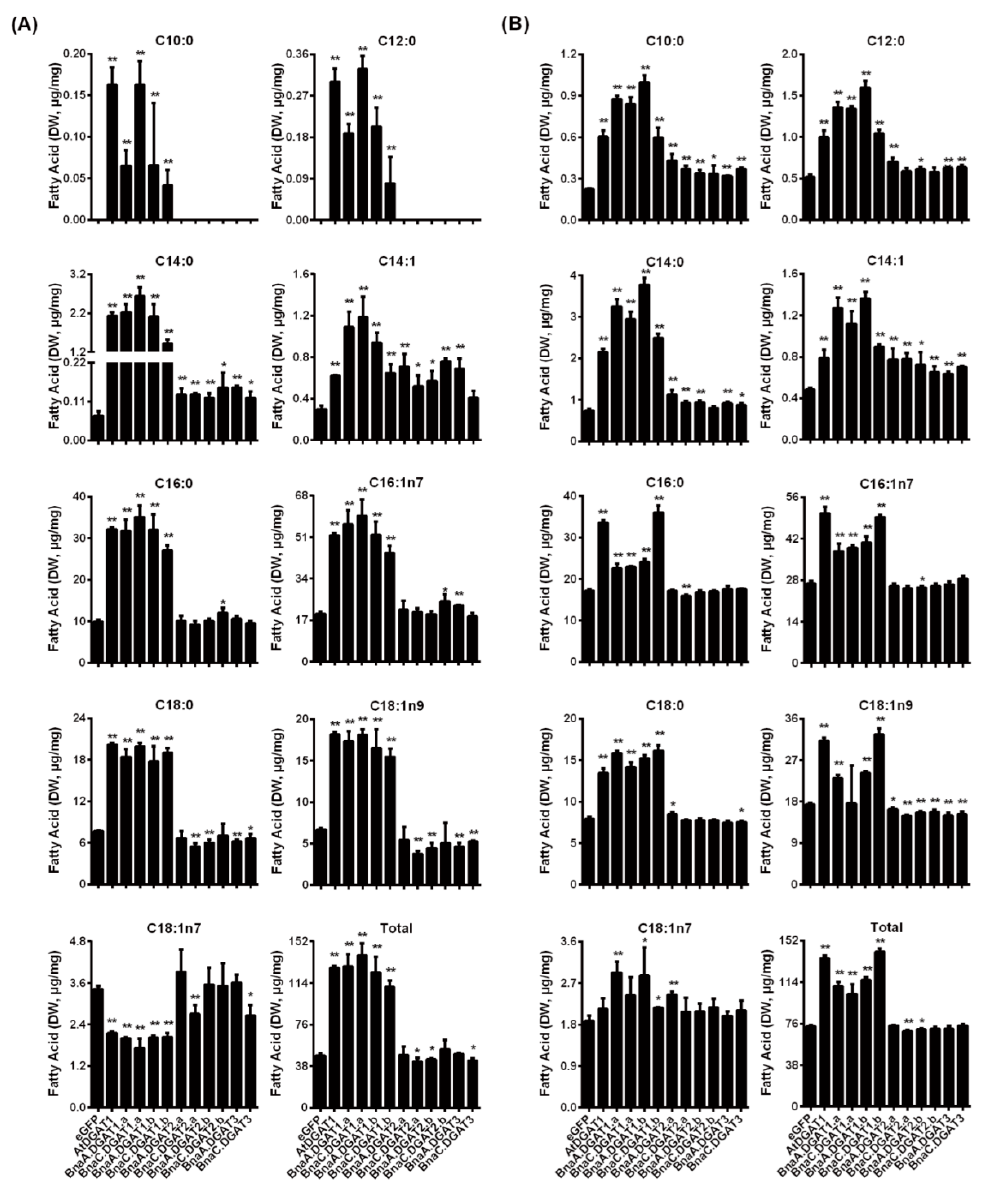
Figure 5. Analysis of the fatty acid compositions and content in yeast H1246 and INVSc1 expressing different BnaDGATs . ( A ) Yeast H1246; ( B ) Yeast INVSc1. Yeast expressing eGFP was the negative control, and that expressing AtDGAT1 was the positive control. Data represent averages of three replicates ± SD. Statistical analysis was carried out by Student’s t test. Asterisks indicate the fatty acids with a significant difference from those in the negative control (* p < 0.05; ** p < 0.01).